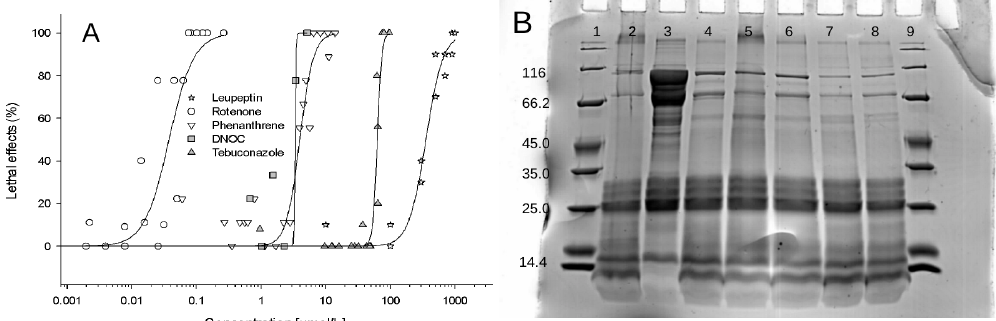
Figure 3. Concentration–e ff ect relationships of the lethal e ff ects of the five test substances, rotenone, DNOC, phenanthrene, tebuconazole and leupeptin, on zebrafish embryos after 48 h of exposure ( A ). Concentration–e ff ect relationships were modelled using the three-parameter sigmoidal logistic function (Hill) f = a*xˆb / (cˆb + xˆb) (for parameters, see Table 1). Each data point represents the mean of 10 embryos of the tested concentration. ( B ) SDS-PAGE from protein samples of total embryo homogenates of untreated (controls) and treated embryos. Treatment included the exposure to the respective LC 10 concentrations of all five test substances for a duration of 48 h. Lanes 1 and 9: protein marker, 2: control, Table 1. Chemical identities, physicochemical properties and model parameters from concentration–effect relationships established for lethal (FET) and sublethal e ff ects after the exposure of zebrafish embryos to the five test